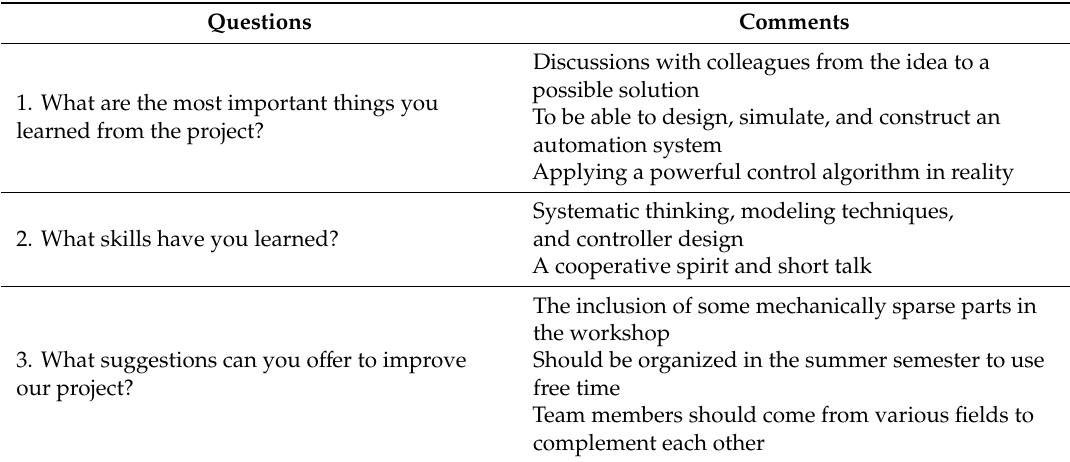
Table 10. Learners’